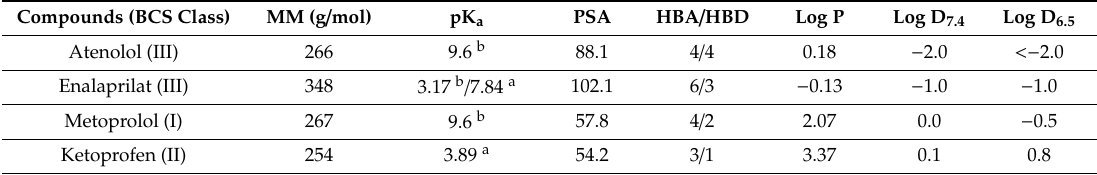
Table 1. Some physicochemical properties and Biopharmaceutics Classification System (BCS) classification of the four model drugs